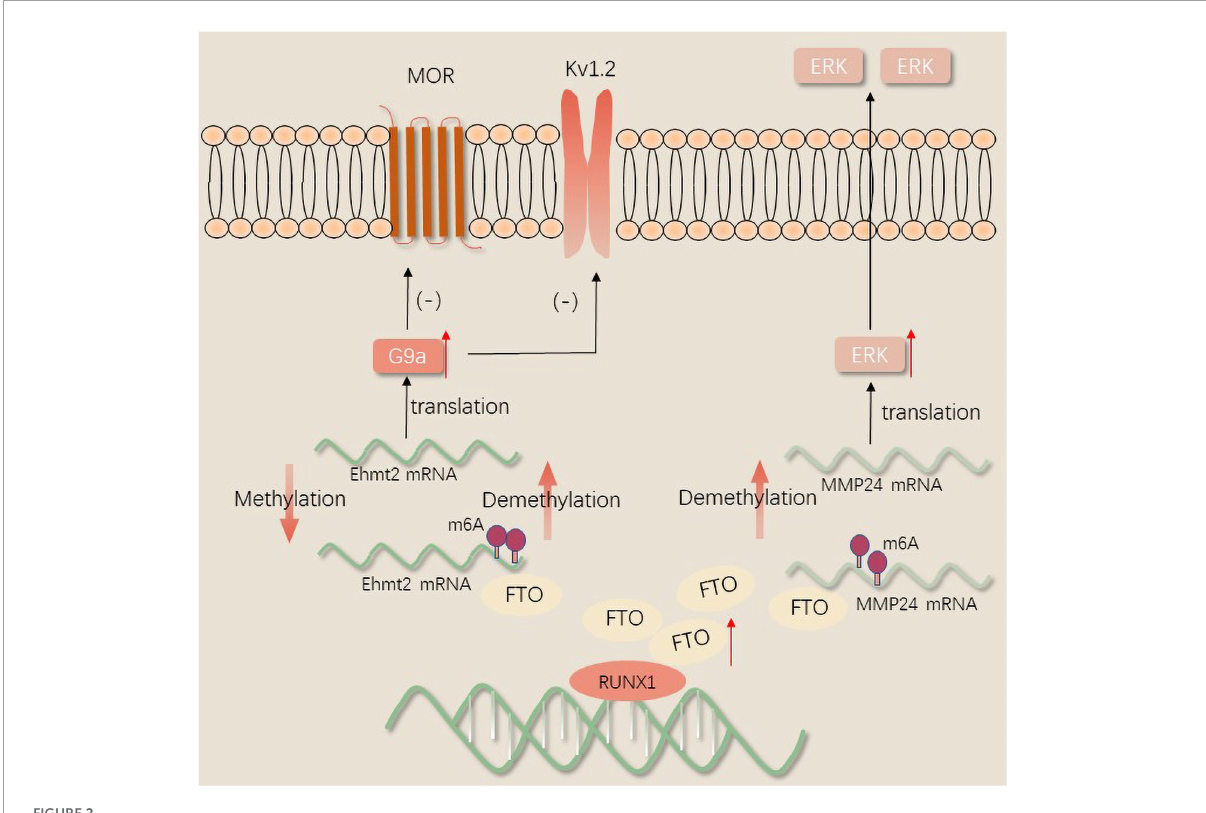
FIGURE2 The mechanism of FTO regulates neuropathic